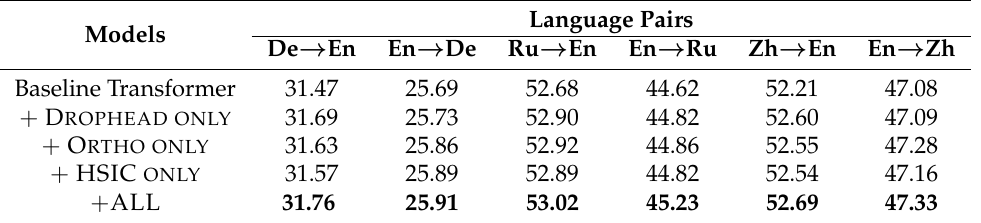
Figure 4. SVCCA coefficient curves of inter-head similarity with controlling methods. Table 6. BLEU evaluation on various language pairs with controlled inter-head similarity on WMT17 corpus and UN